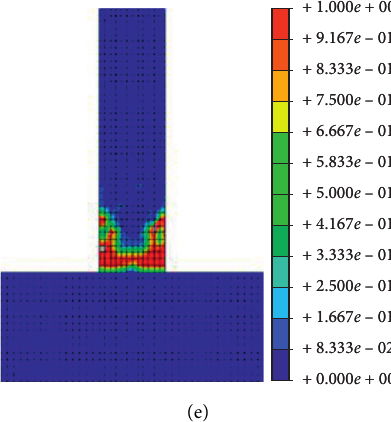
Figure 5: Prediction of the behavior of column tested by Du [43]. (a) Column specimen. (b) Force-displacement response. (c) Damage in tension prediction. (d) Damage in plastic hinge zone at the end of the test. (e) Damage in compression